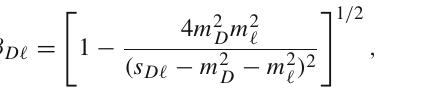
Fig. 2 Radiative corrections to the branching ratios of ¯ B 0 → D + (cid:2) − ¯ ν (cid:2) (left) and B − → D 0 (cid:2) − ¯ ν (cid:2) (middle) decays, as a function of E max . The long-distance QED corrections to R ( D + ) (orange) and R ( D 0 ) (violet) asafunctionof E max (right). Theplotsareobtainedfrom simulateddata